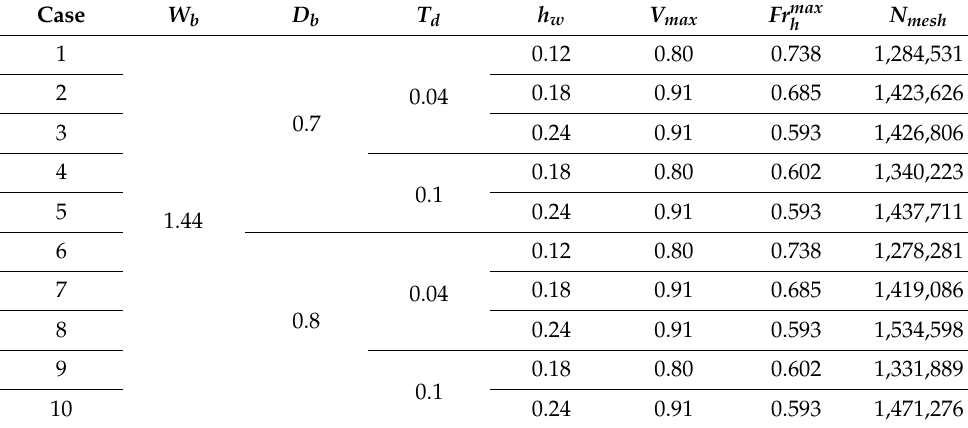
W , distance between bridge piers D , draught T and water depth b b d V is (m/s). max Fr is the maximum depth-Froude max h V max